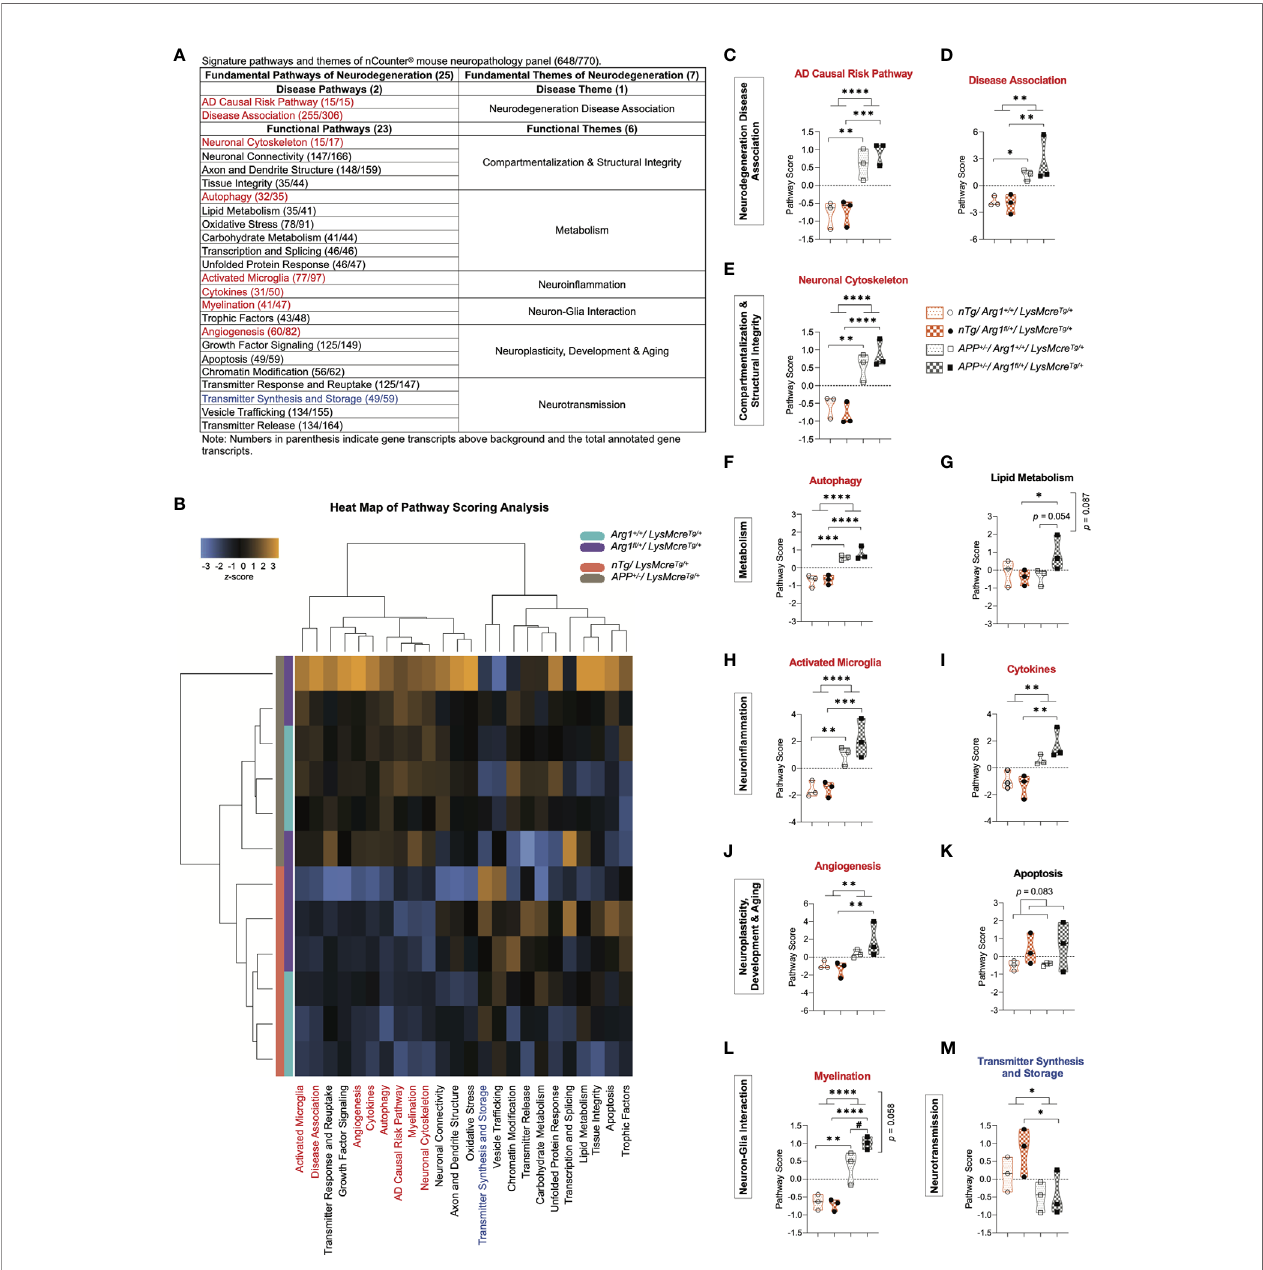
FIGURE 2 | Pathway scoring analysis of fundamental neurodegeneration pathways. (A) A table of signature pathways and themes of nCounter ® mouse neuropathology panel. A total of 25 fundamental signature pathways are mapped into seven themes covering one disease theme and six functional themes. (B) A heat map of pathway scoring analysis provides an overview of pathway distribution and clustering across all samples. Score color in orange or blue indicates up or down-regulation of each pathway in each sample, respectively. All scores are presented on the same scale via a z -transformation. (C, D) Scores for pathways of AD causal risk pathway (C) and disease association (D) under the theme of neurodegeneration disease association. (E) Score for the pathway of neuronal cytoskeleton under the theme of compartmentalization & structural integrity. (F, G) Scores for pathways of autophagy (F) and lipid metabolism (G) under the theme of metabolism. (H, I) Scores for pathways of activated microglia (H) and cytokines (I) under the theme of neuroin fl ammation. (J, K) Scores for pathways of angiogenesis (J) and apoptosis (K) under the theme of neuroplasticity, development & aging. (L) Score for the pathway of myelination under the theme of neuron- glia interaction. (M) Score for the pathway of transmitter synthesis and storage under the theme of neurotransmission. All samples are displayed in violin plots with the median denoted as a line. Within each pathway, score values from four groups have been centered to a mean of zero. Pathways that show statistically signi fi cant main APP transgene genotype effects are highlighted in red or blue to indicate up or down-regulation, respectively. n=3 samples per group representing 6 mice. The asterisk sign (*) indicates the main effect of APP transgene genotype and its pair-wise comparisons. The number sign (#) indicates the main effect of the Arg1 haploinsuf fi ciency genotype and its pair-wise comparisons. Interaction of the two genotypes is indicated vertically by the p values. * /# p < 0.05; ** p < 0.01; *** p < 0.001; **** p < 0.0001. Two-way ANOVA of 2x2 factorial analysis followed by pairwise comparisons using Fisher ’ s